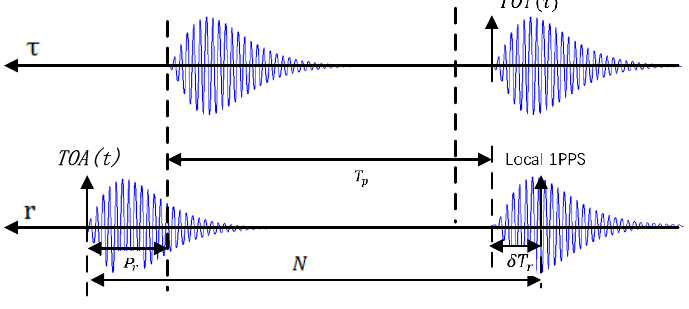
Figure 2. The schematic diagram of propagation delay.